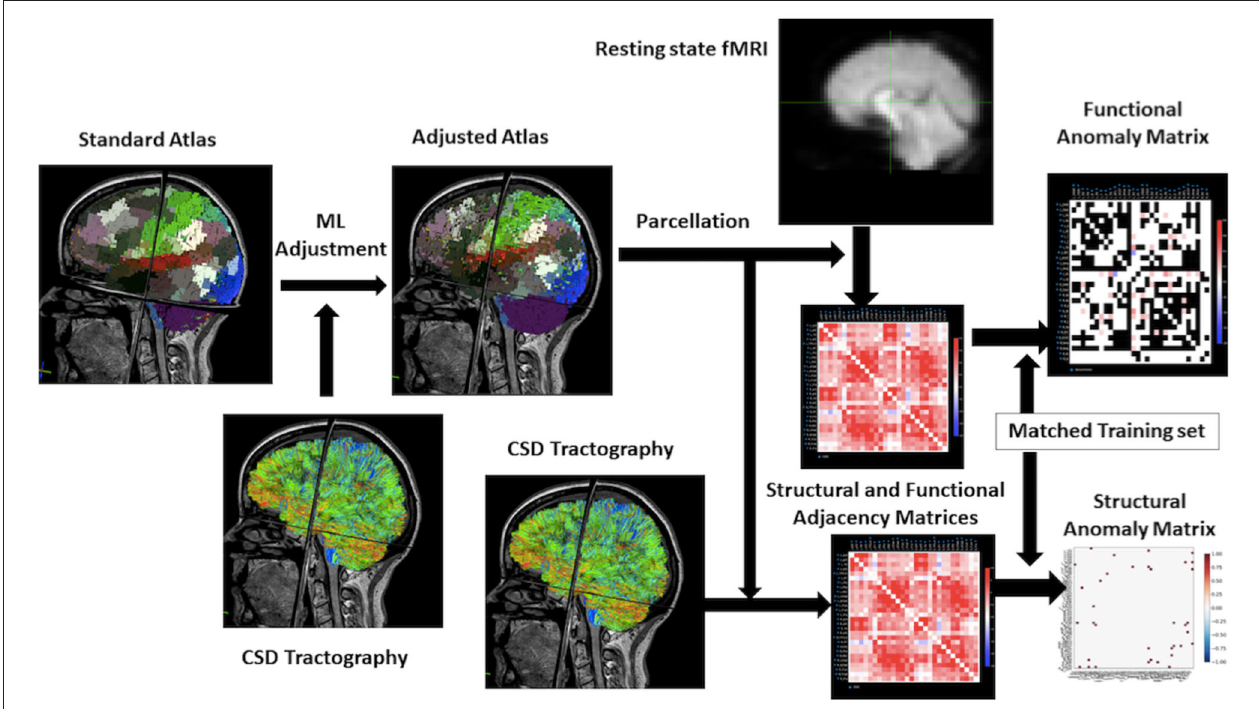
FIGURE 1 | Workflow for the research. From the upper left to the right of this flowchart: the research starts with a standard atlas warped onto the brain, the boundaries are smooth because it is not machine learning–based. Then using the constrained spherical deconvolution–based tractography to adjust the atlas to personalize it. Process the rsfMRI to a functional matrix and structural MRI to a structural matrix by taking parcellation of atlas. The final step will be utilizing a training set in machine learning to make an anomaly matrix of structural and functional connectivity for further analysis.